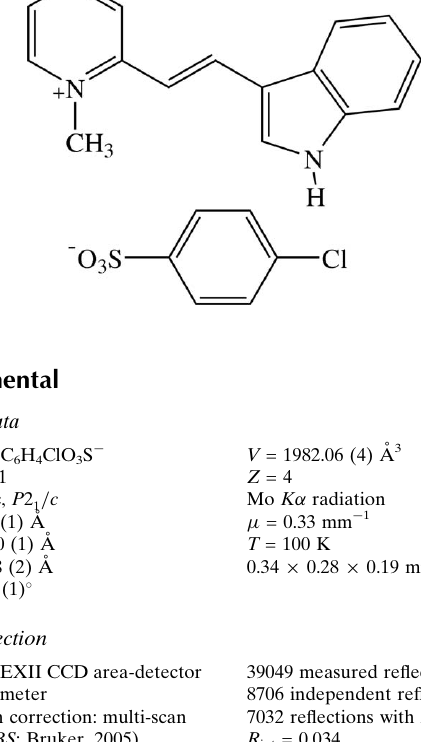
Bruker APEXII CCD area-detector diffractometer Absorption correction: multi-scan ( SADABS ; Bruker, 2005) T min = 0.899, T max = 0.942